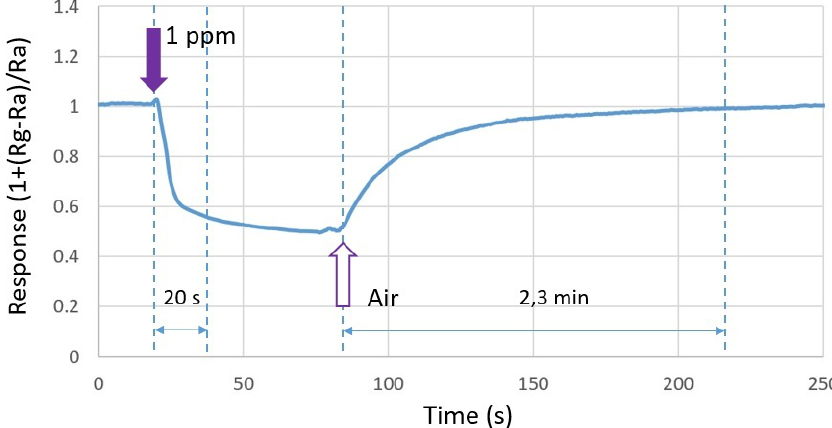
Figure 10. Response time and recovery time of the composite heater design with respect to 1 ppm of